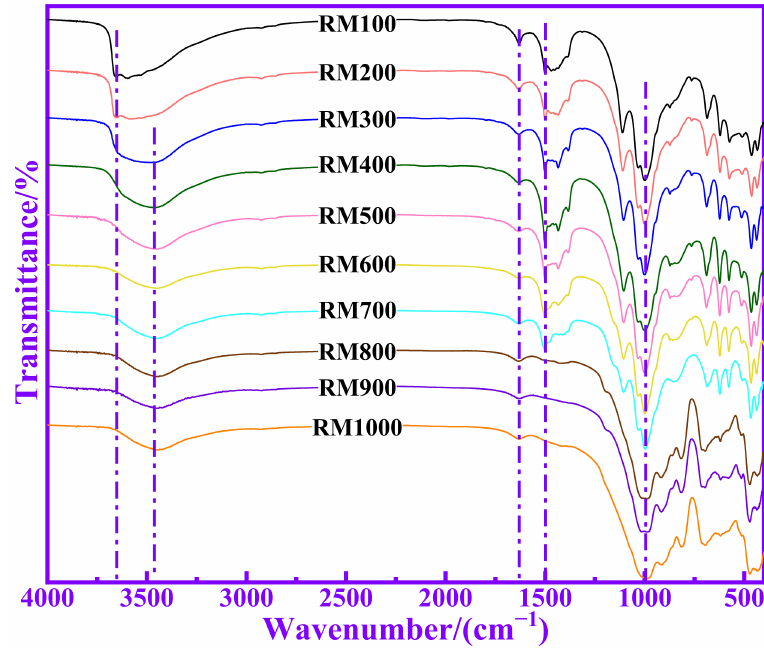
Figure 6. The FTIR spectrum of calcined RM at different